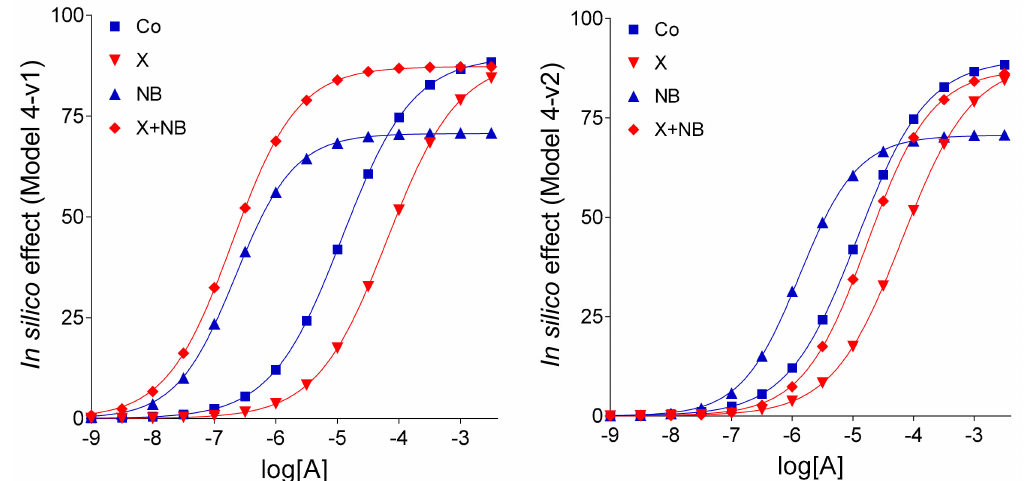
Figure 4. Simulated concentration-response (E / c) curves of agonist A (representing adenosine, the physiological adenosine receptor agonist with short half-life), according to Models 4-v1 and 4-v2 (modelling the atrial myocardium, where A 1 adenosine receptor agonists evoke strong direct negative inotropy). The E / c curves denote the influence of agent NB (modelling NBTI, a nucleoside transport inhibitor) on the e ff ect of agonist A, without (blue curves) and with (red curves) a pretreatment with agent X (representing FSCPX, a chemical known as an irreversible A 1 adenosine receptor antagonist). The x -axis shows the common logarithm of the molar concentration of agonist A (in the organ bath), and the y -axis denotes the e ff ect. The lines represent the fitted Hill equation (see: Equation (4)). FSCPX: 8-cyclopentyl- N 3 -[3-(4-(fluorosulfonyl)benzoyloxy)propyl]- N 1